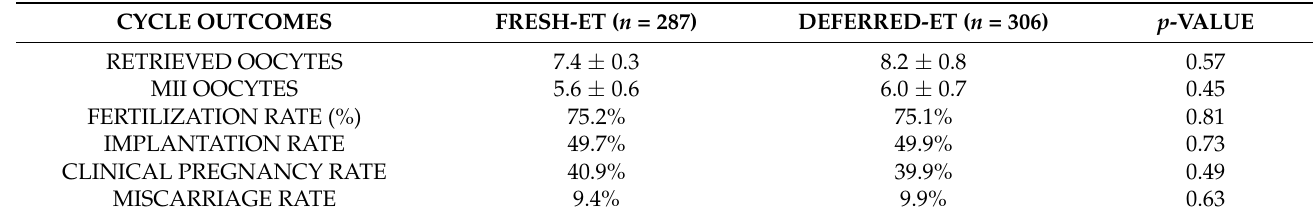
Table 2. IVF-ICSI outcomes in non-PGT-A